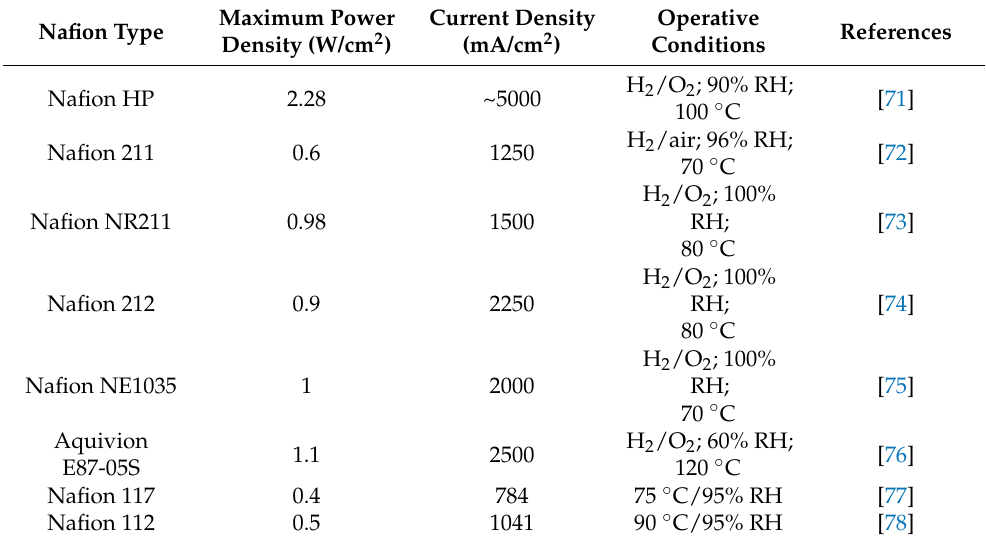
Table 6. Nafion membranes ( RH stands for relative